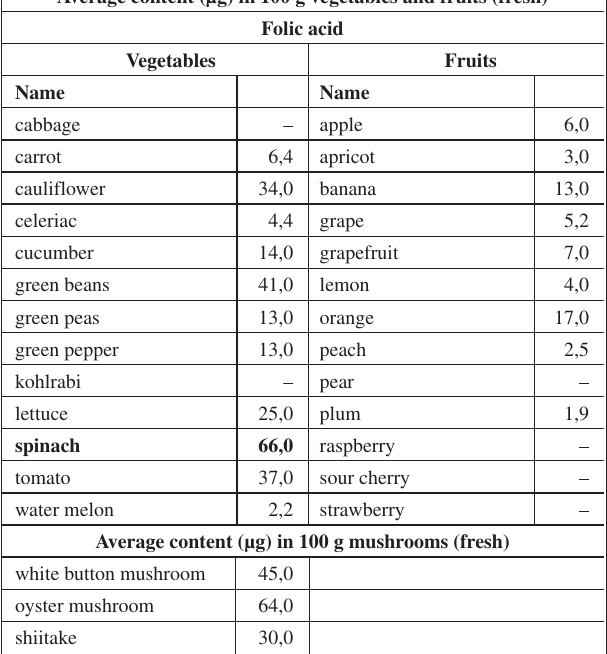
Table 7. Average folic acid content (µg) in 100 g vegetables, fruits and mushrooms (fresh)